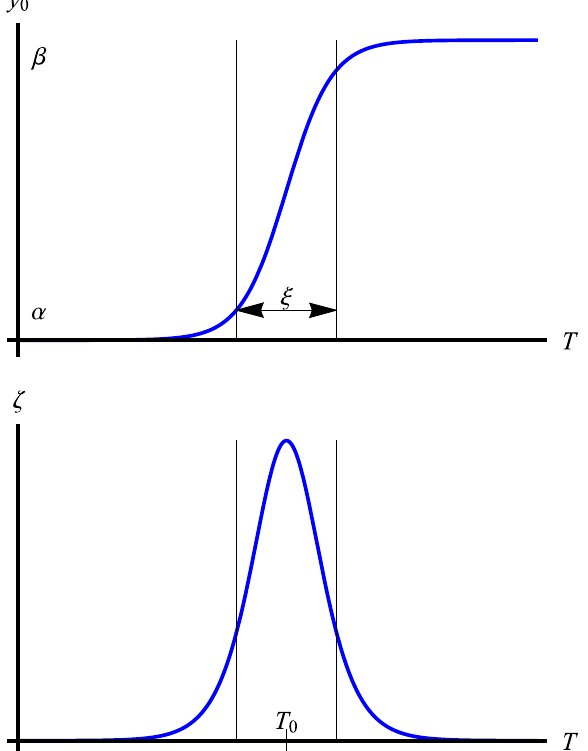
Figure 13. Schematic plots of α/β phase transition in equilibrium. Top : the hyperbolic tangent profile of y 0 corresponding to two coexisting phases in the span of ξ . Bottom : The slope of the profile ζ the sharpness of the